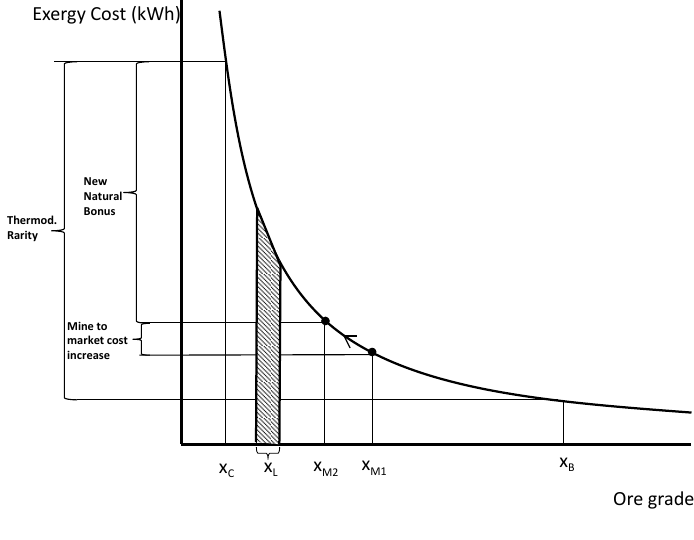
Figure 4. The influence of extraction on thermodynamic rarity, should technology remain constant.